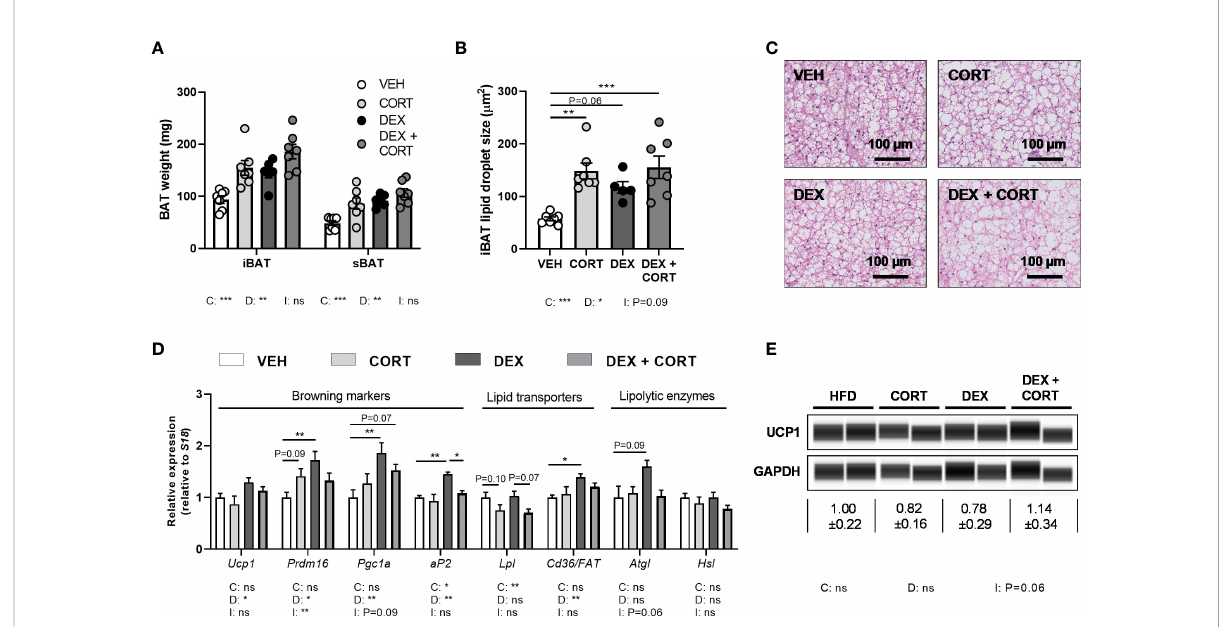
FIGURE 4 Dexamethasone increases expression of BAT activation markers genes, which is counteracted by corticosterone add-on treatment. Mice received a high-fat diet mixed with dexamethasone (DEX) or vehicle (VEH) and were subcutaneously implanted with low-dose (5 mg) corticosterone (CORT) or vehicle pellets for 3.5 weeks. (A – C) CORT and DEX increased the weight of interscapular brown adipose tissue (iBAT) and suprascapular brown adipose tissue (sBAT), and increased the lipid content of iBAT, as determined by H&E staining. (D) In iBAT, DEX increased expression of Ucp1 , Prdm16 , Pgc1a , aP2 , Cd36/FAT and Atgl , which was (partially) reversed by CORT add-on treatment. (E) None of the treatments affected UCP1 protein expression in sBAT. Statistical signi fi cance was calculated using 2-way ANOVA analysis. Depicted below the graphs are the P-values of the ANOVA tests for either CORT (C), DEX (D) or the interaction between CORT and DEX (I). *P < 0.05, ** P < 0.01, ***P < 0.001. 'ns' means 'not signi fi